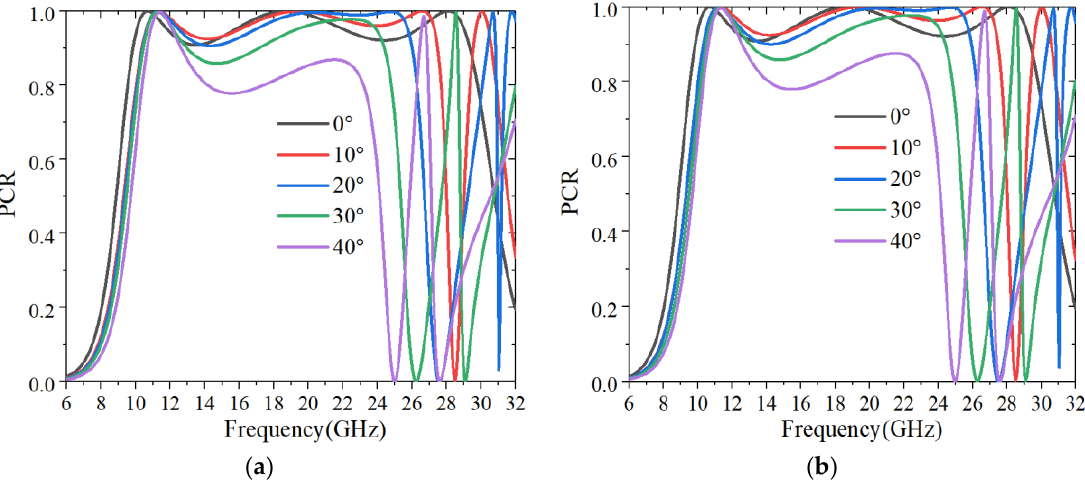
Figure 5. The PCR under different oblique incidences for ( a ) x -polarized wave; ( b ) y -polarized wave.